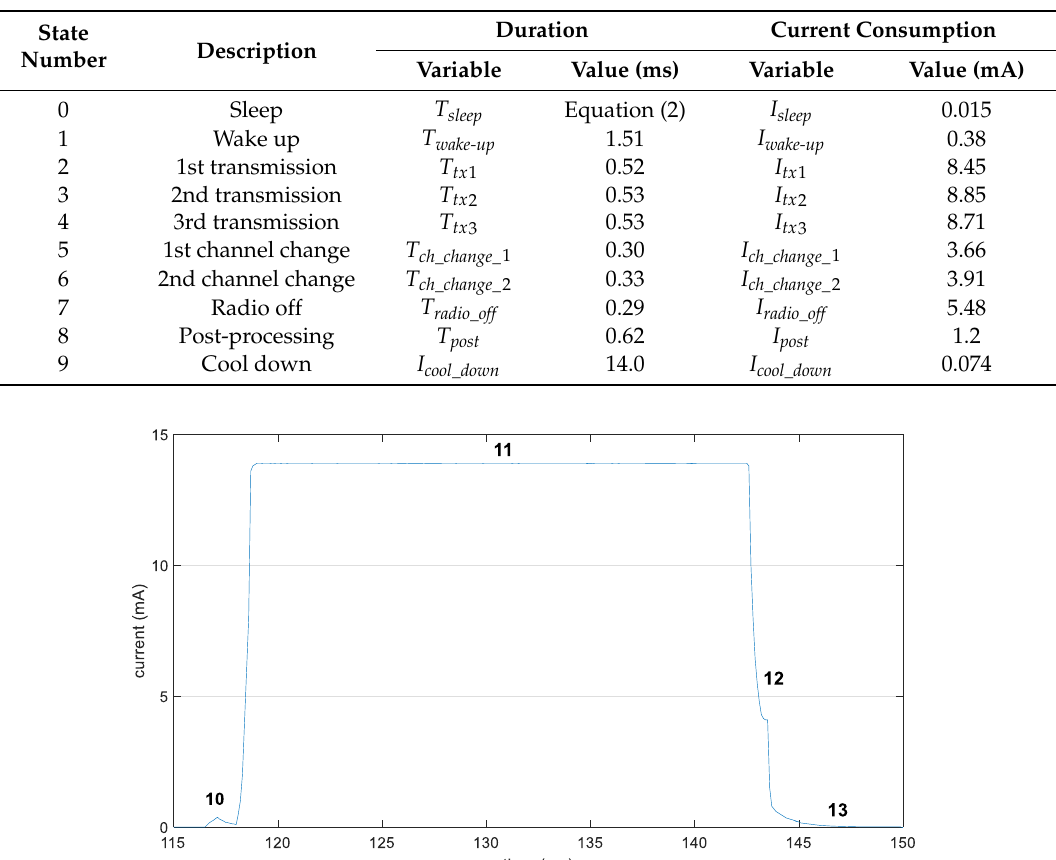
Figure 7. Current consumption of an nRF51422 Development Kit for the states related with performing a scan interval.